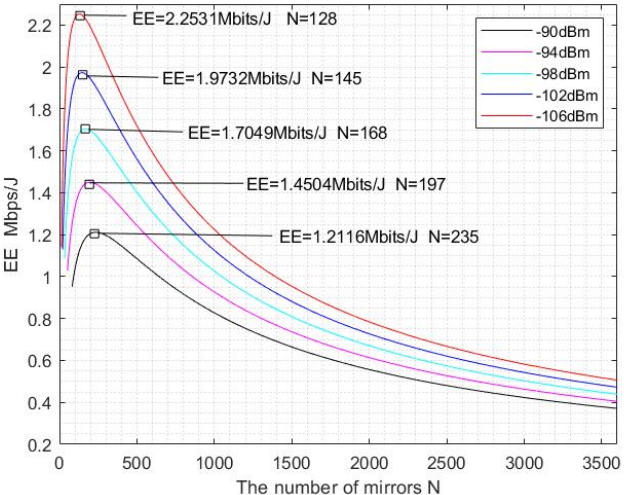
Figure 5. EE versus N with different noise power σ 2 . As can be seen from Figure 5, (cid:1831)(cid:1831)((cid:1840)) increases first and then decreases with different noise power (cid:2026) (cid:2870) , which is a unimodal function. When the number of mirrors in IRS is con- stant, the EE becomes larger with the smaller noise power. When the number of mirrors